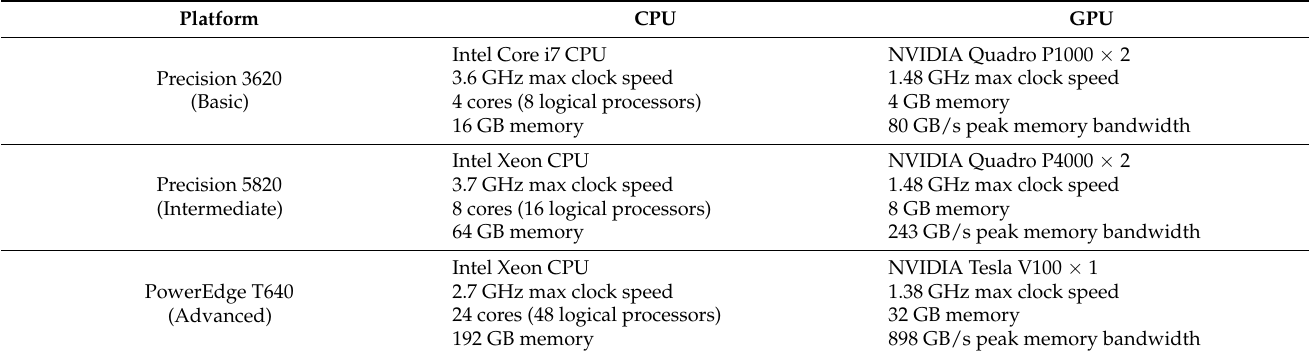
Table 1. Specifications of the three computing